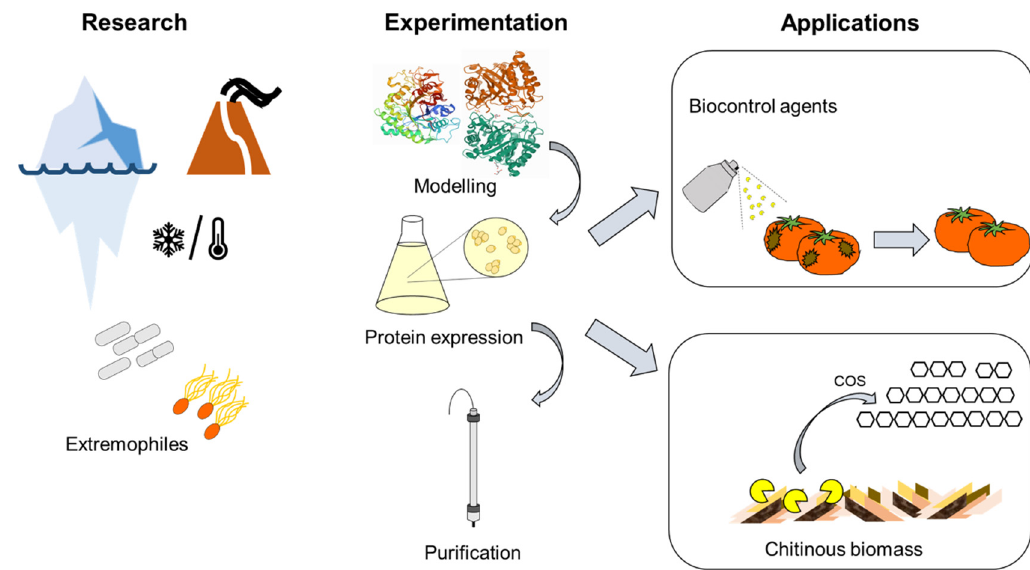
Figure 8. Perspectives linked to the agricultural uses of improved chitinases. Research involving the modeling of ex- tremozymes and rational design can lead to superior catalysts in terms of stability. Such enzymes can be expressed in heterologous hosts, purified, and used as biocontrol agents or to degrade chitinous waste to yield chitooligosaccharides (COSs). COSs can in turn be applied as elicitors to improve biotic stress responses in crops.